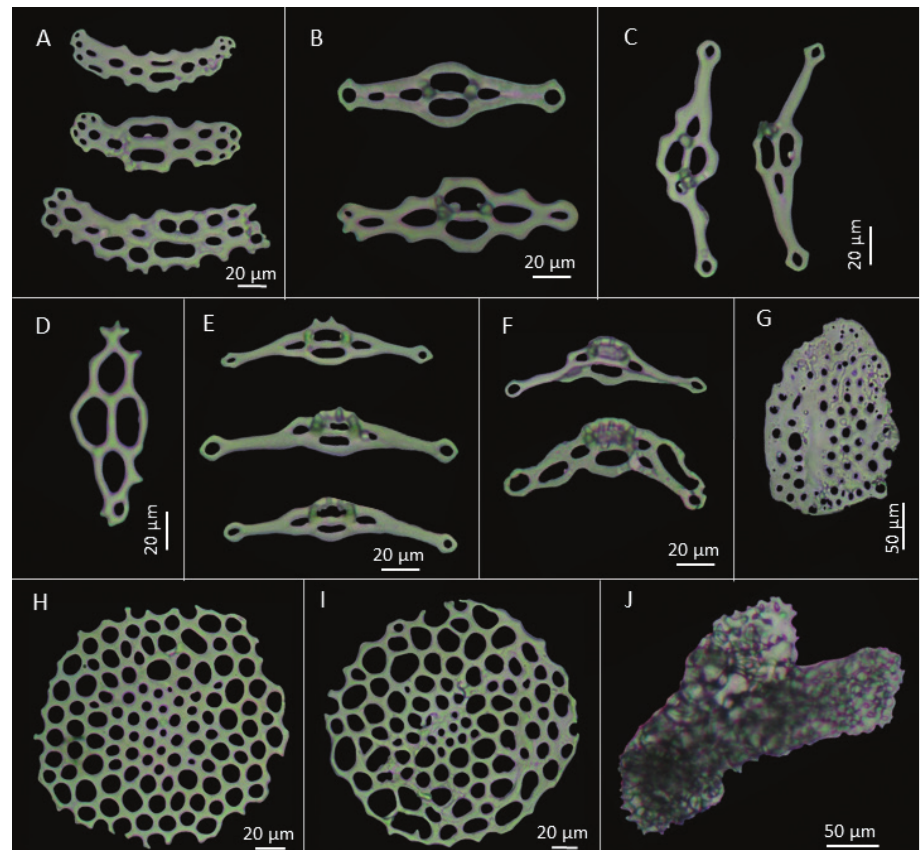
Figure 3. Pentamera paraibanensis sp. n. A Support plates from ventral body wall B Base of support tables from ventral tube feet C Curved base of support tables from ventral tube feet D Support plate of tube feet E Support tables from ventral tube feet F Curved support tables from ventral tube feet G Large plate from body wall near the anus H Endplate from dorsal tube feet I Endplate from ventral tube feet J Anal